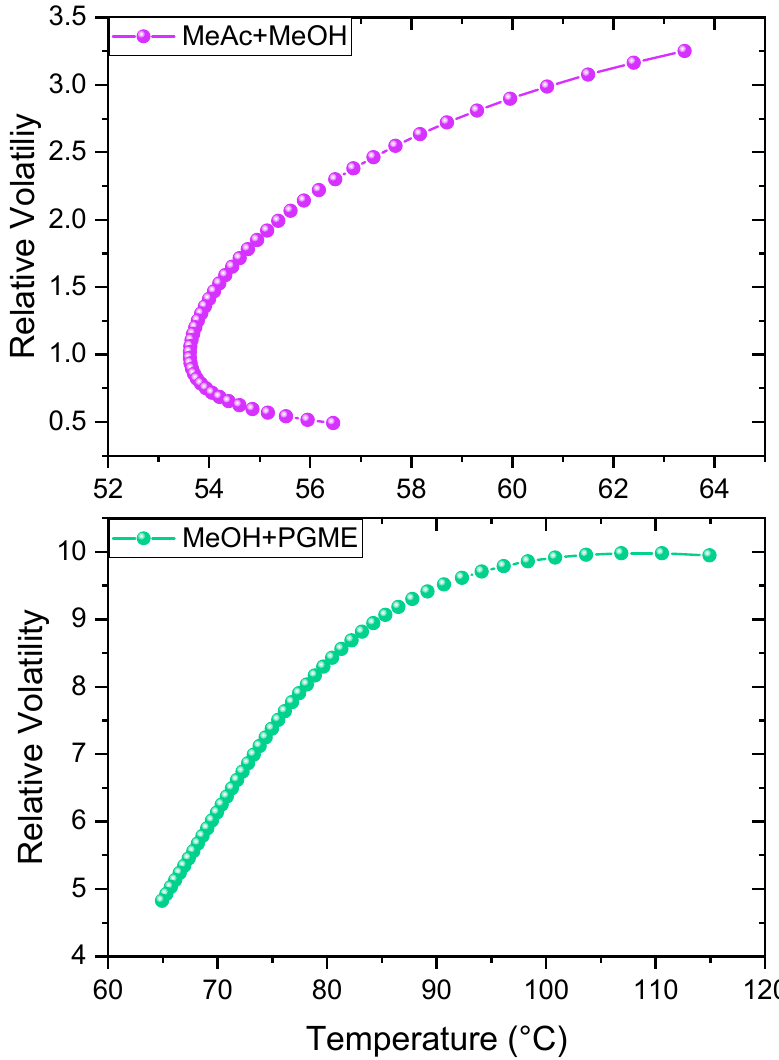
Figure 4. Relative volatility of MeAc and MeOH and MeOH and PGME within temperature interval. To conceptually design the DWC, the column requires a prefractionator to split the middle BP into the top and bottom streams. This column conforms to the preferred separation [27] in which the column operates at double pinch or the lowest energy required to eliminate the remixing effect [28]. The preferred separation lever rule line is almost perpendicular to the medium BP and inside the feasible region in total [27]. To